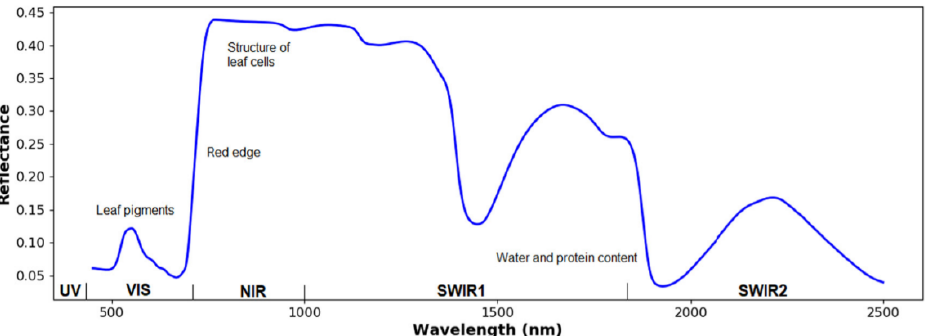
Figure 2. Illustration of a typical reflectance spectrum of a green leaf. UV, VIS, NIR, and SWIR refers to ultraviolet, visible spectrum, near-infrared, and short-wave infrared, respectively [41]. Near-infrared light is affected by the structure of leaf cells, while the SWIR light is dominated by water and protein content.